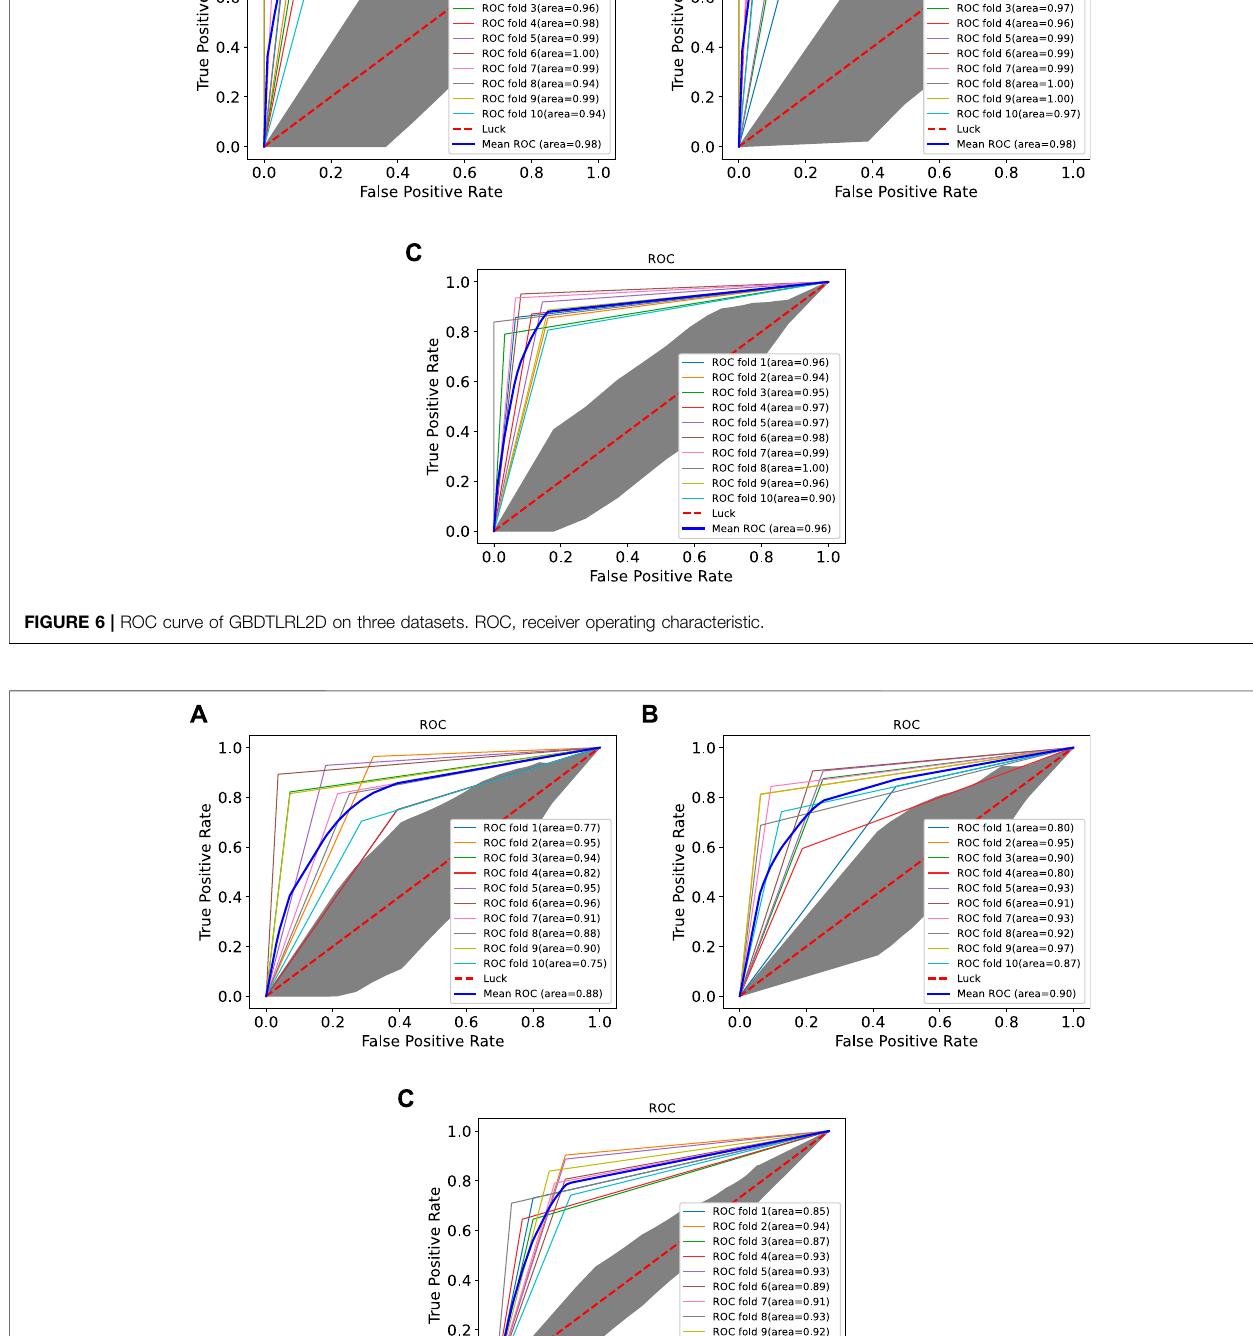
Frontiers in Cell and Developmental Biology |